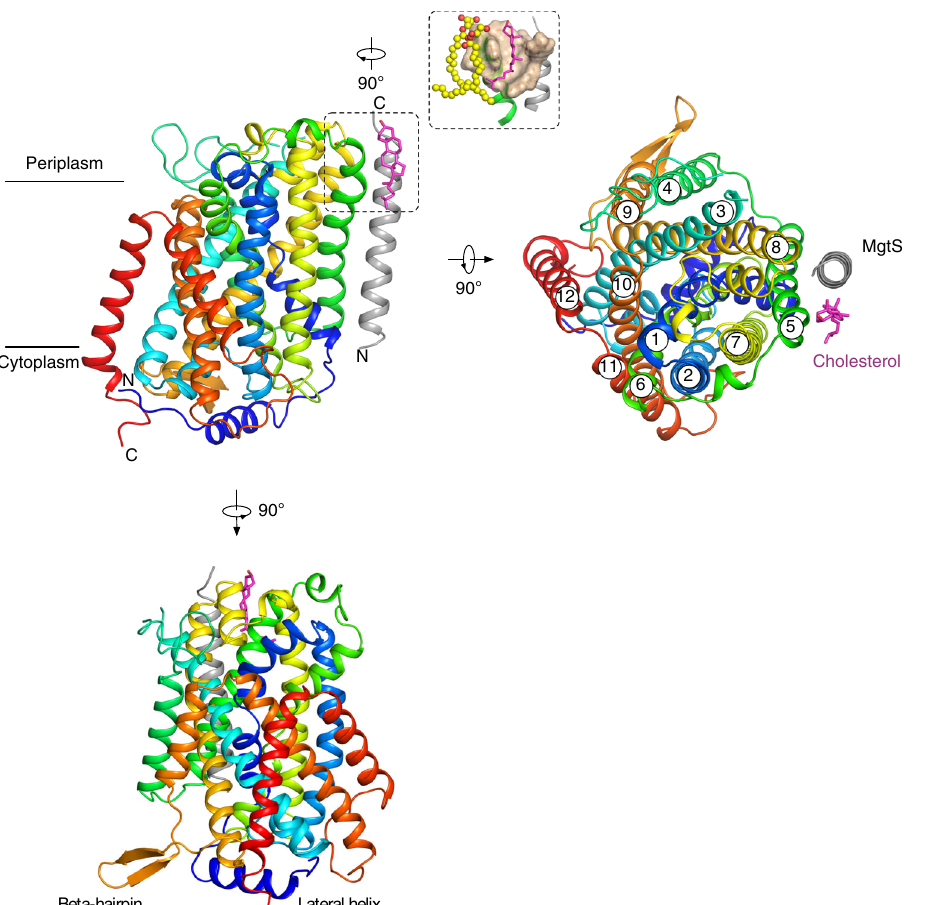
Fig. 1 Crystal structure of GkApcT. Crystal structure of GkApcT-MgtS heterodimer at 2.86 Å. Helices are coloured blue to red from the N-termini. MgtS is coloured grey and the bound cholesterol pink. Inset, a close-up view of the cholesterol binding site made between GkApcT and MgtS. Two monoolein lipids are also observed close to the cholesterol binding site and shown as